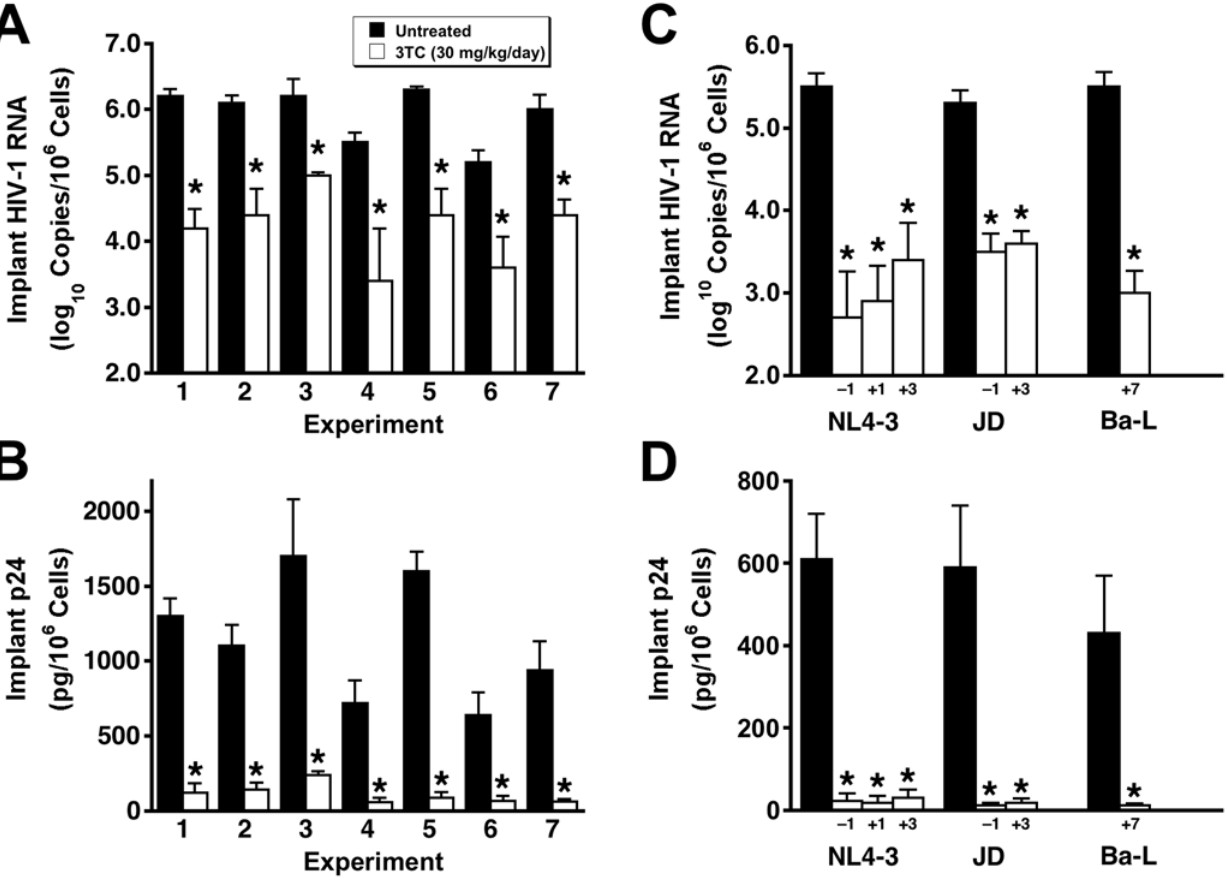
Figure 1. Implant viral loads in untreated- and 3TC-treated SCID-hu Thy/Liv mice are highly reproducible, and 3TC treatment after HIV-1 inoculation is nearly as effective as prophylactic treatment. A, HIV-1 RNA in Thy/Liv implants of untreated mice and mice treated by twice-daily oral gavage with 3TC at 30 mg/kg per day beginning 1 day before inoculation with NL4-3 (means 6 SEM) Each experiment was performed in a mouse cohort made with tissues from a single donor. B, Implant p24 for the same groups as in panel A. C, Implant HIV-1 RNA in mice treated with 3TC beginning on day 2 1, day + 1, day + 3, and day + 7 with respect to inoculation with the indicated HIV-1 strains. D, Implant p24 for the same groups as in panel C. Implants were collected 21 days after inoculation for NL4-3, 14 days for JD, and 42 days for Ba-L. *p # 0.05, compared with untreated mice for 5–7 mice per group.